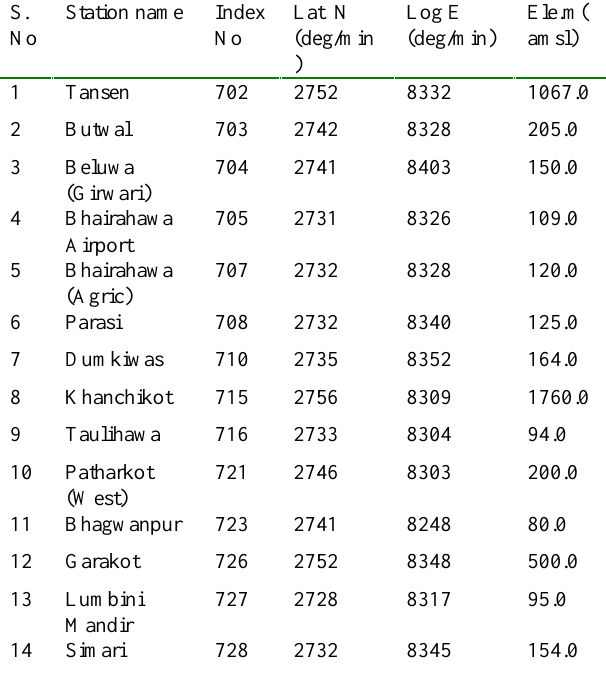
Table 1. Rainfall station site characteristics